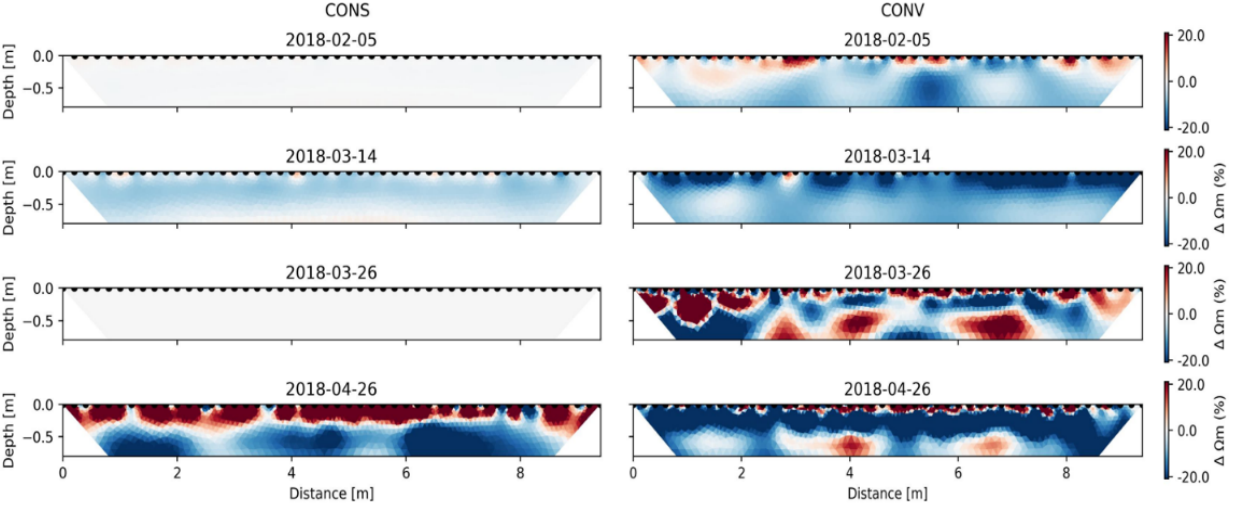
Figure 6. Comparison of time-lapse ER differences between the background time (19 December 2017) and the following times, respectively, for the conservative ( left ) and the conventional treatment ( right ).